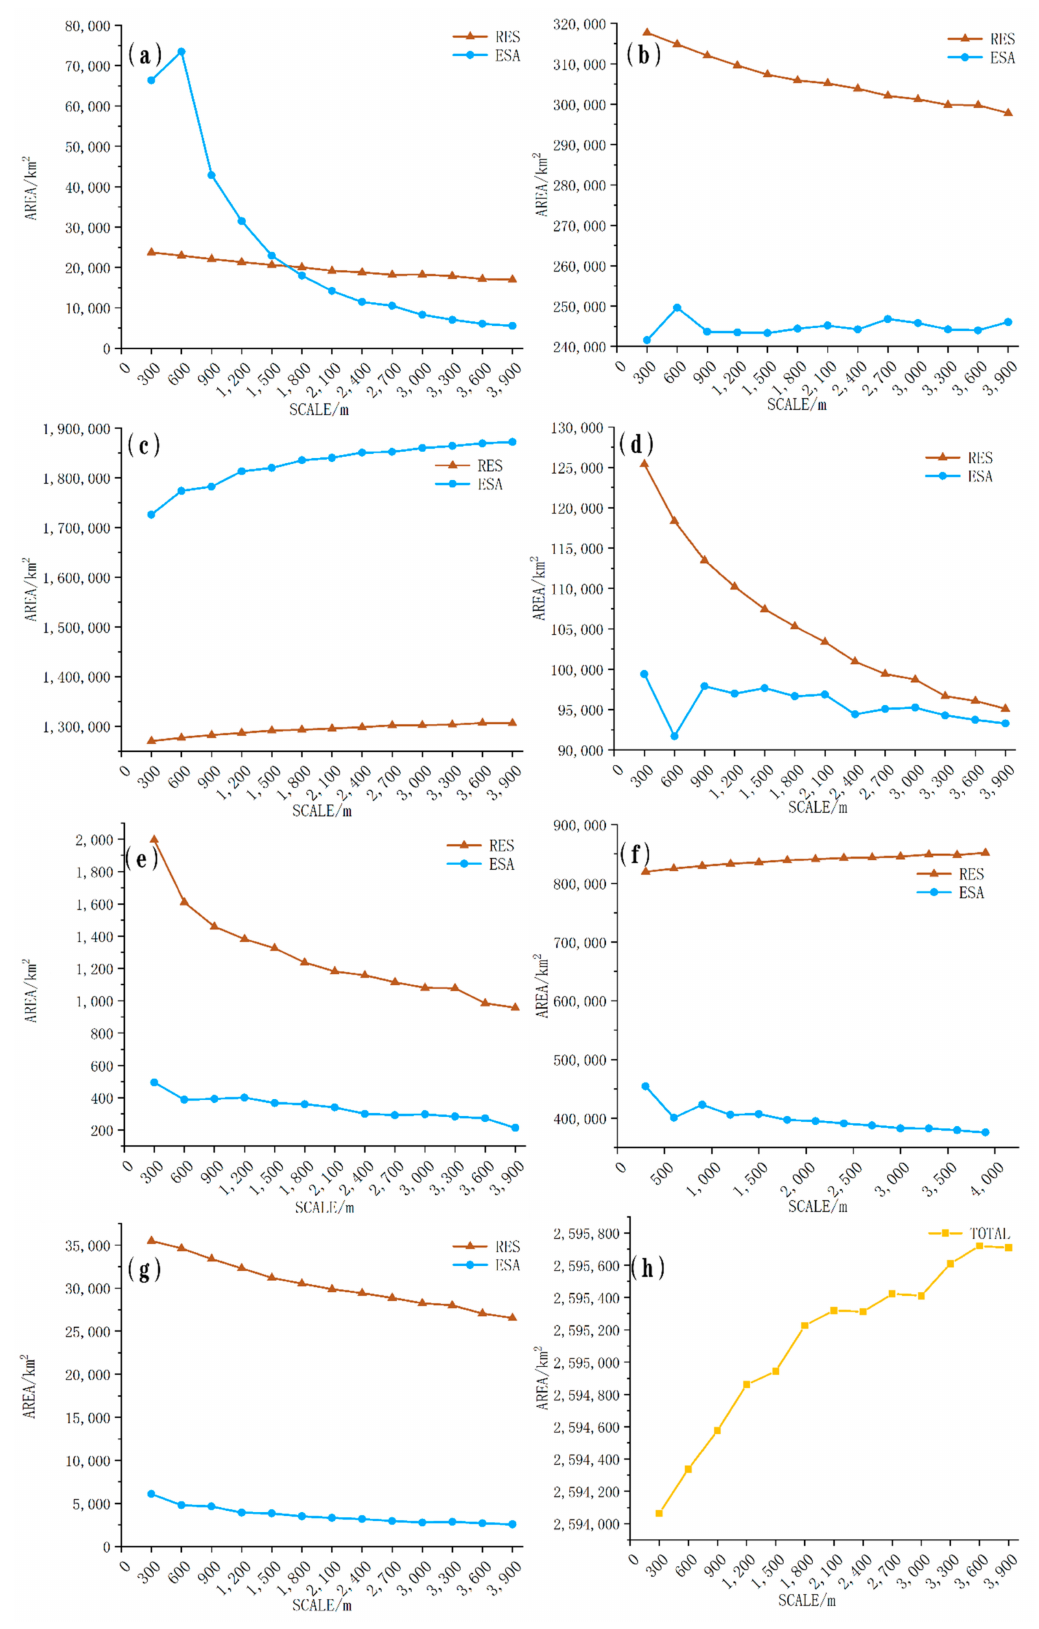
Figure 3. The areas of CL ( a ), WO ( b ), GL ( c ), WA ( d ), CO ( e ), UL ( f ), and WL ( g ) and the overall areas of RES and ESA ( h ) at different